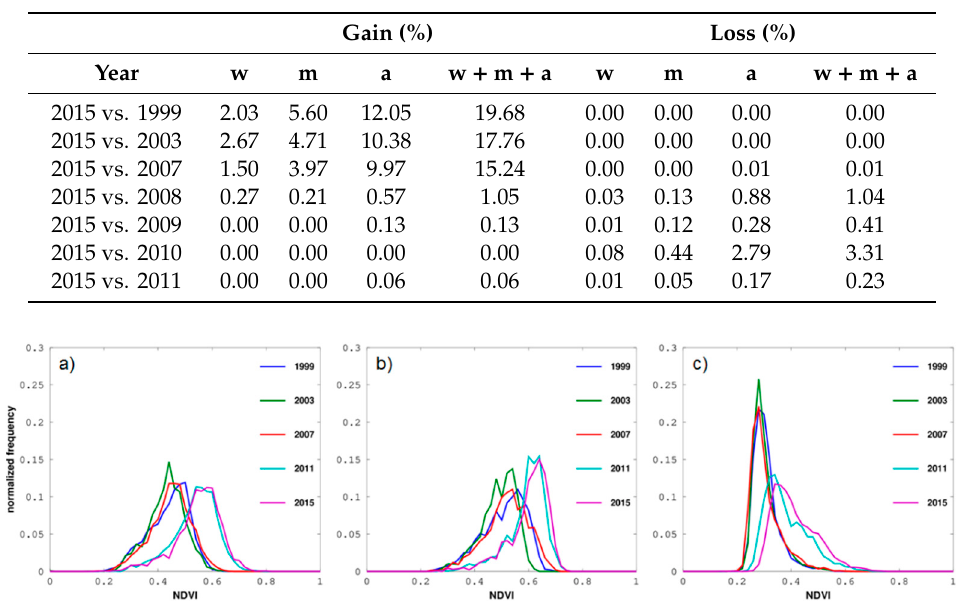
Figure 8. Temporal change of normalized frequency distribution for the surface reflectance (SR) normalized difference vegetation index (NDVI) Landsat data during the 1999–2015 period in three different land cover classes of Pianosa Island: ( a ) woodland; ( b ) Mediterranean macchia; ( c ) abandoned crops and pastures.